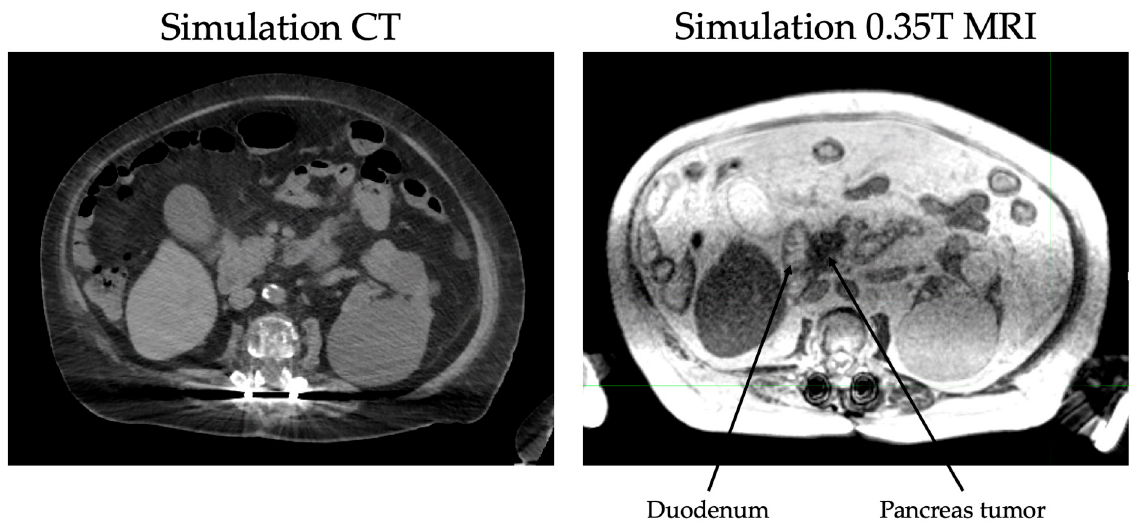
Figure 1. CT vs. MRI at simulation for a patient with pancreas head adenocarcinoma. Dosimetric Benefit of MRgRT